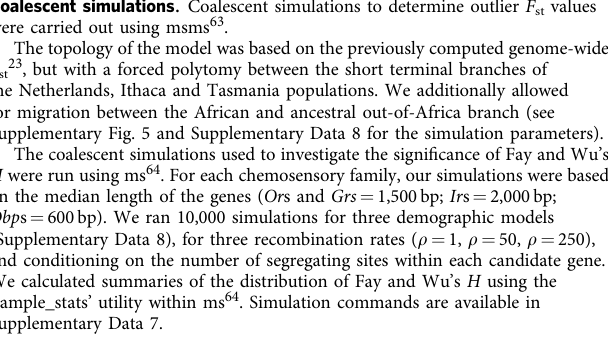
Supplementary Table 6. PCR amplification followed standard protocols followed by Sanger sequencing of the PCR amplicon. Data availability . The sequence and annotation data that support the findings of this study have been deposited in NCBI’s Sequence Read Archive, with the